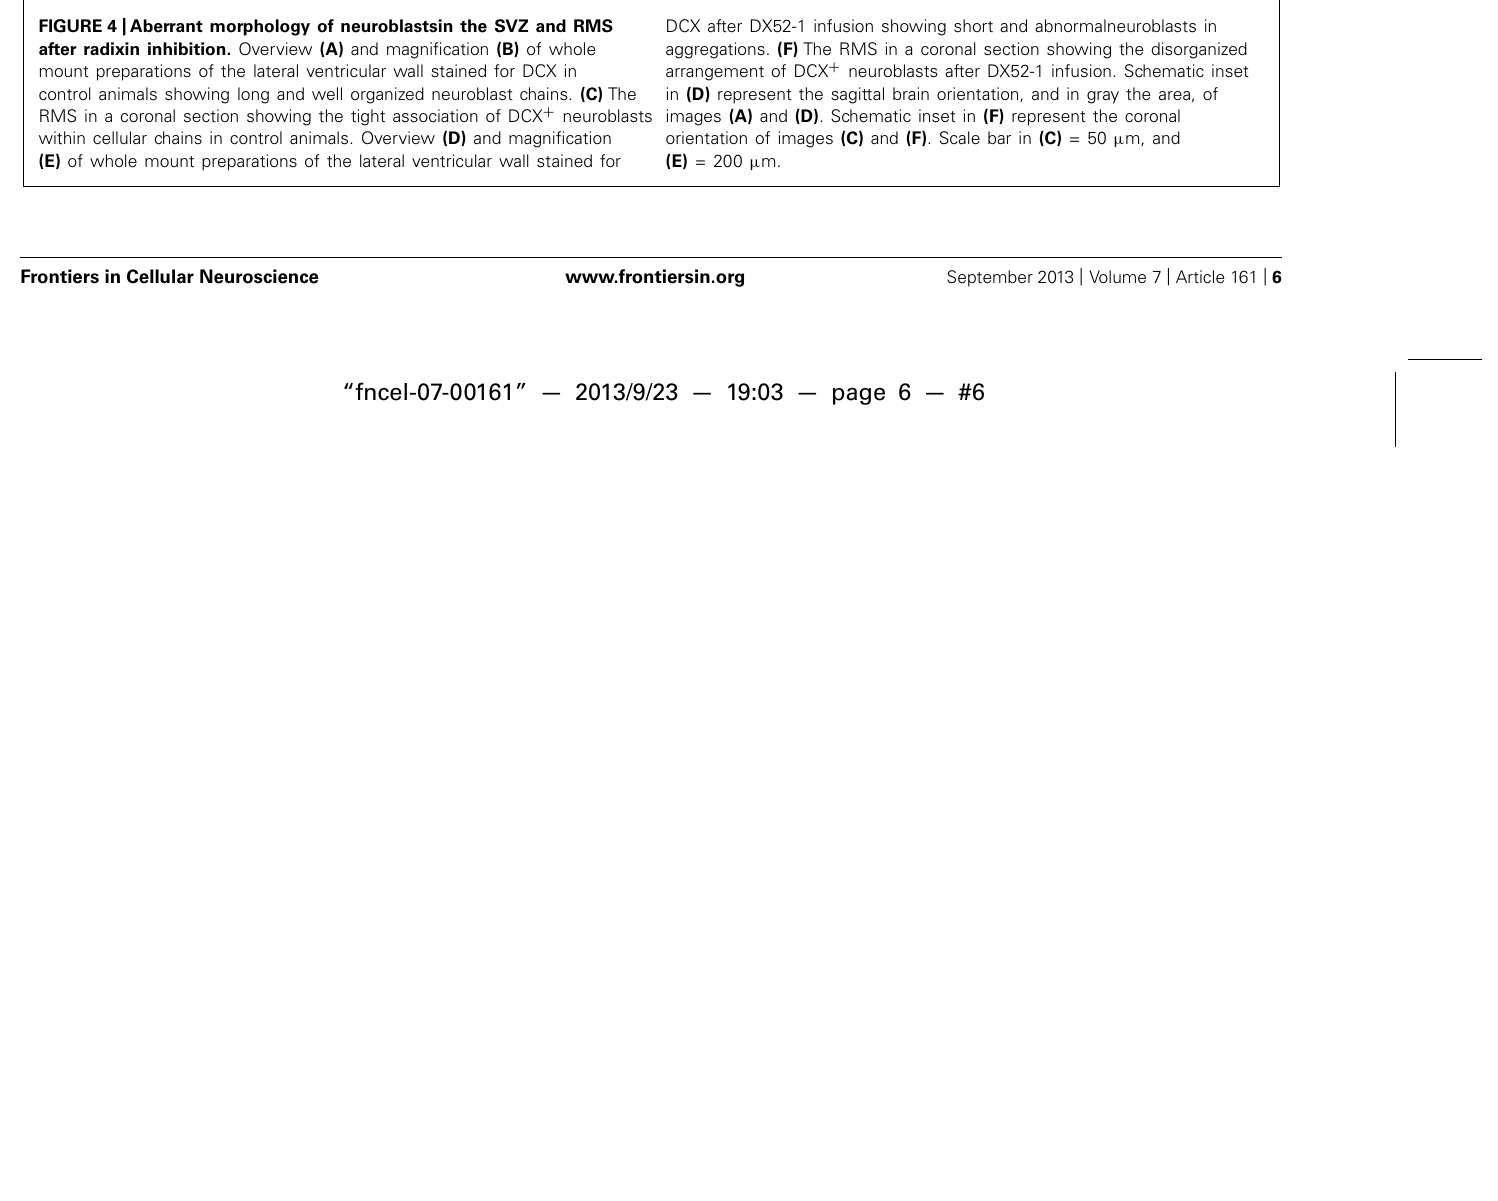
DCX after DX52-1 infusion showing short and abnormalneuroblasts in aggregations. (F) The RMS in a coronal section showing the disorganized arrangement of DCX + neuroblasts after DX52-1 infusion. Schematic inset in (D) represent the sagittal brain orientation, and in gray the area, of images (A) and (D) . Schematic inset in (F) represent the coronal orientation of images (C) and (F) . Scale bar in (C) = 50 μ m, and (E) = 200 μ